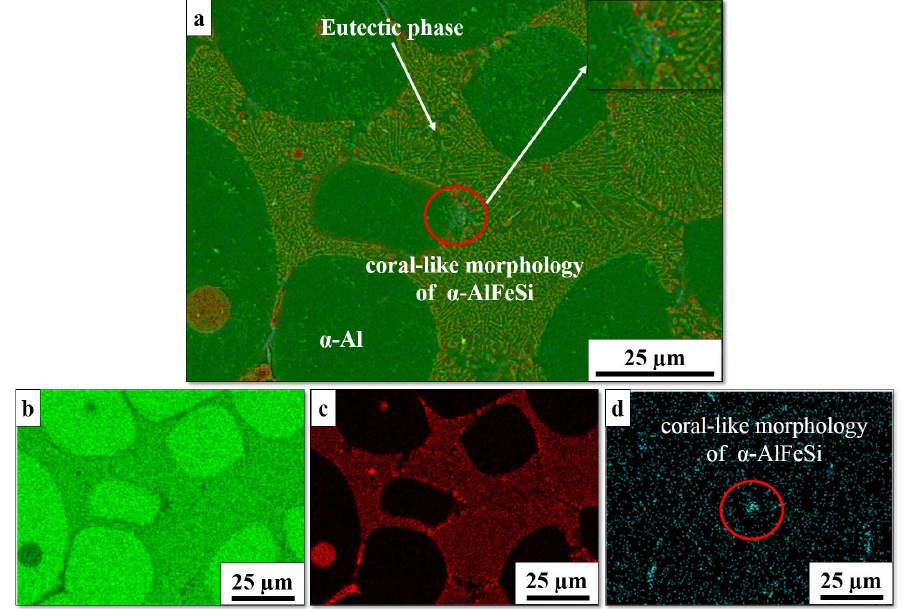
Figure 6. SEM-EDS elemental mapping of Al–7Si alloy: ( a ) SEM morphology of Fe-intermetallic; ( b ) Al; ( c ) Si; ( d ) Fe.